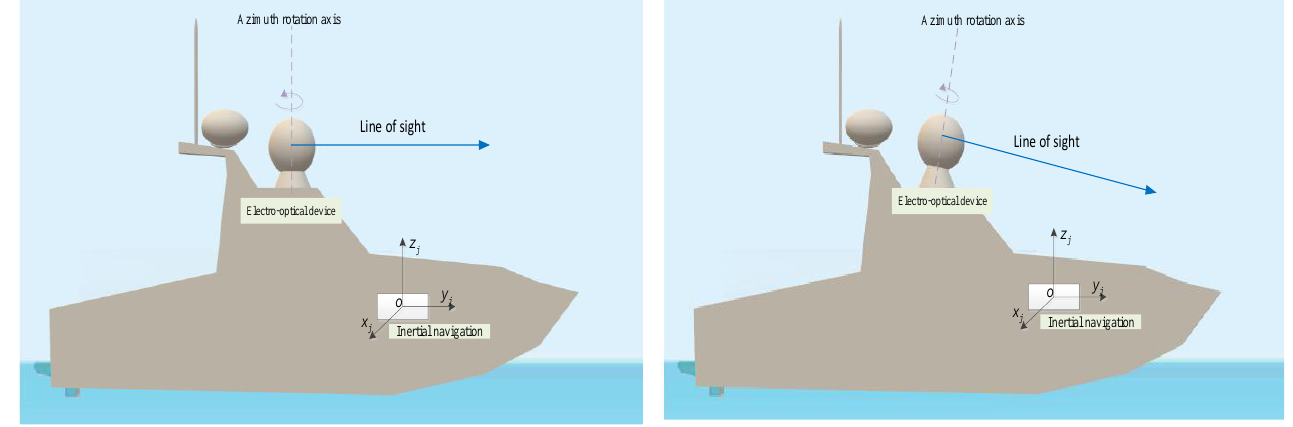
Figure 2. Schematic for the case of a perpendicularity error in installing the electro-optical device.